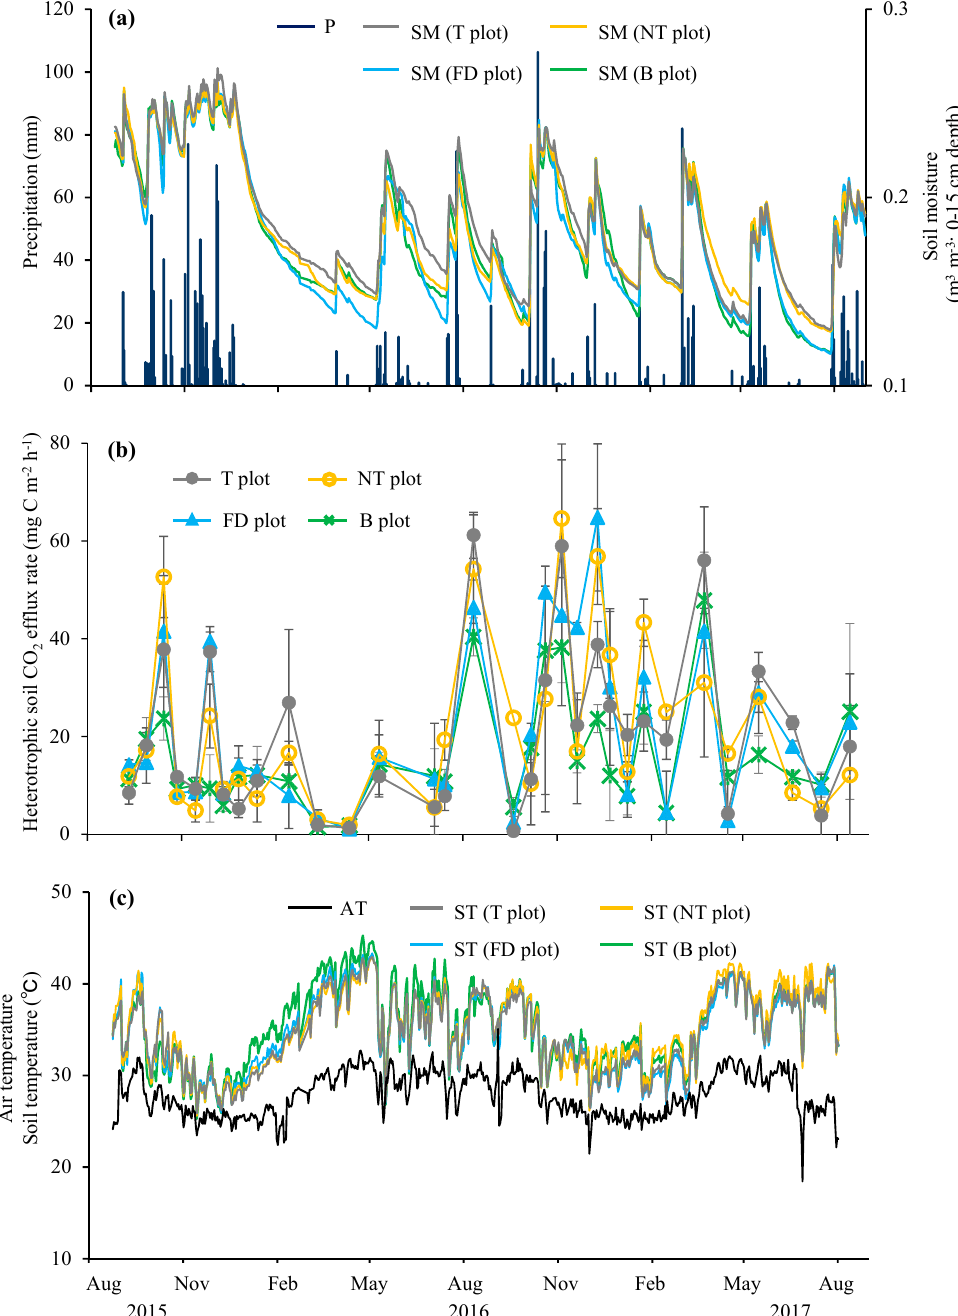
Figure 1. ( a ) Fluctuations in precipitation (P) and soil moisture (SM) (m 3 m -3 : 0–15 cm depth). ( b ) Fluctuations in the heterotrophic soil CO 2 efflux rate during the two-year experimental period. Bars indicate standard error. ( c ) Fluctuations in soil temperature (ST) (5 cm depth). Traditional cultivation management plot (T), fixed density plot (FD), no thinning plot (ND), bare plot (B).